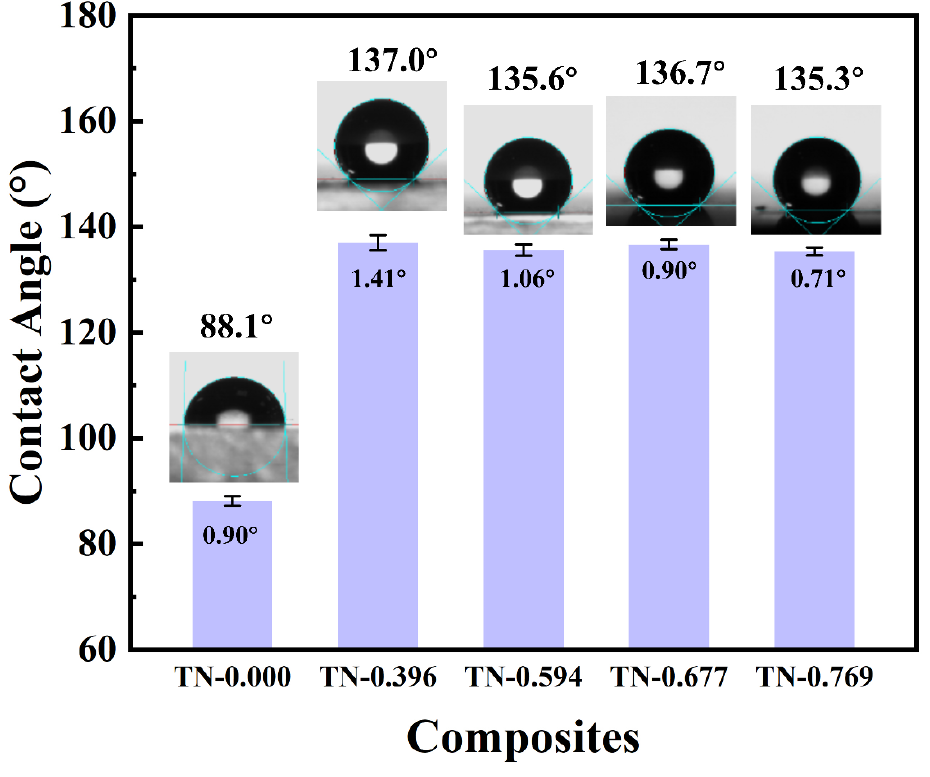
Figure 7. Contact angle of composite TN-0.000, TN-0.396, TN-0.594, TN-0.667 and